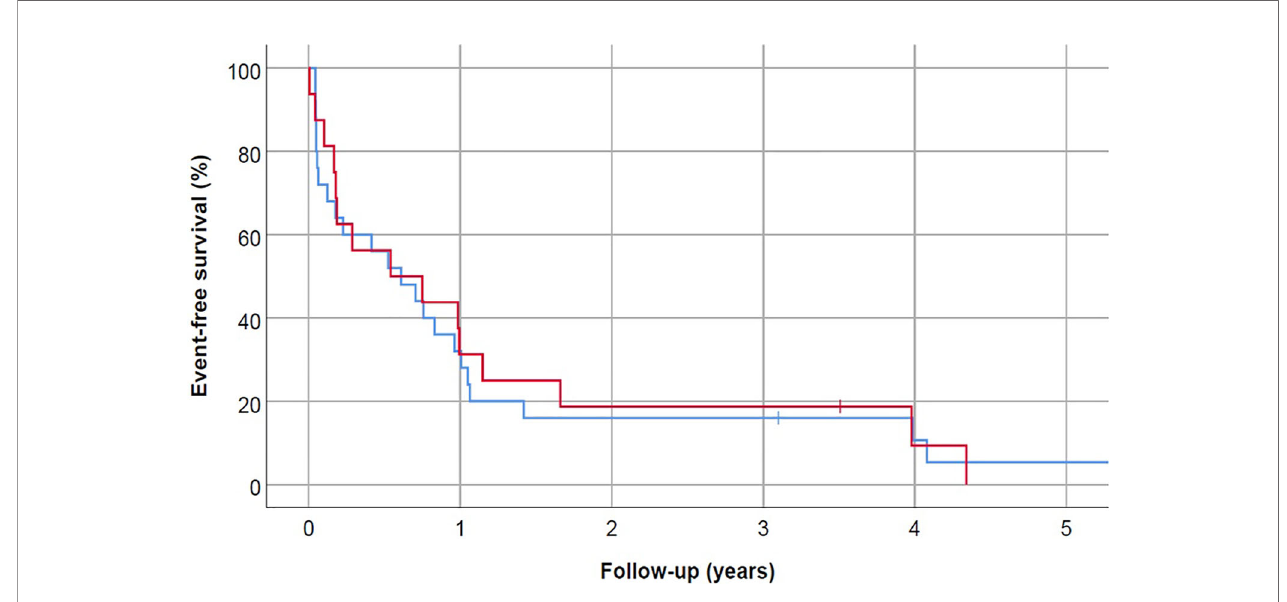
FIGURE 2 | Event-free survival did not correlate with ASPH status (p=0.87). Blue line represents ASPH- negative AML patients and red line is ASPH-positive AML